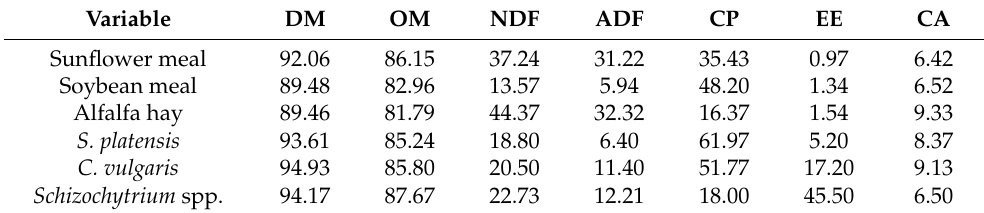
Table 1. Nutritional composition of the substrates (% of